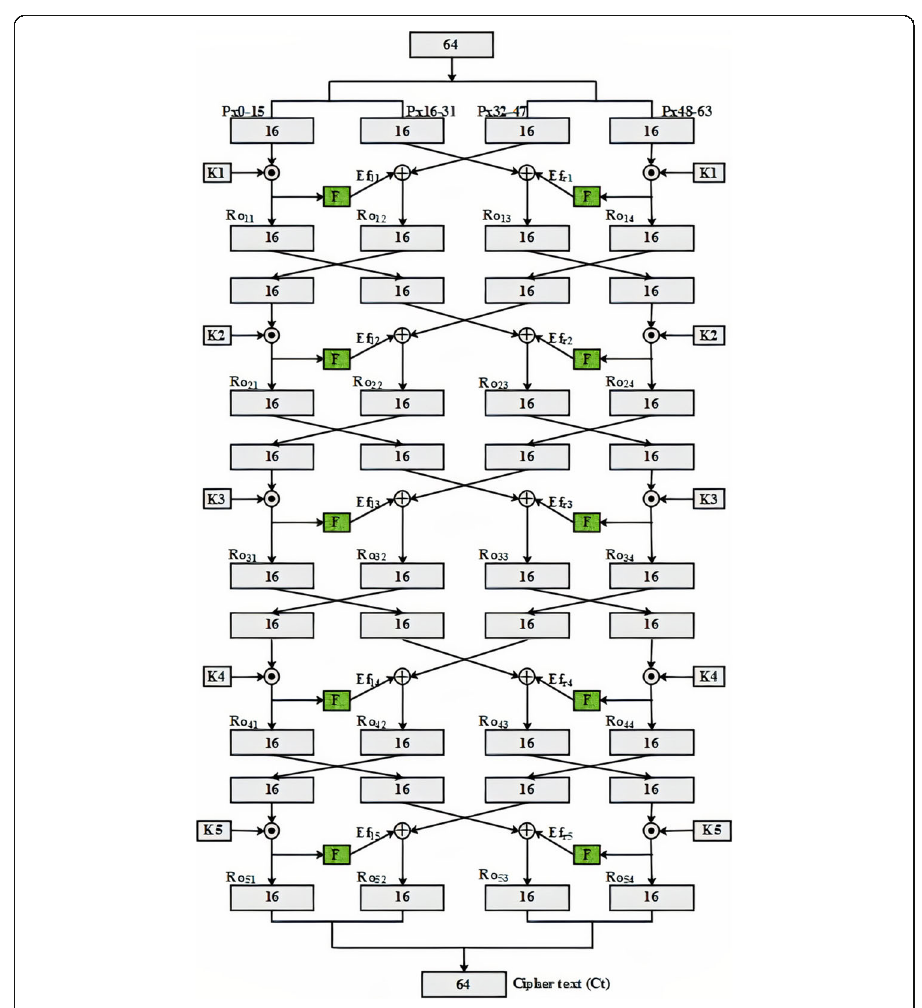
Fig. 8 Encryption process of